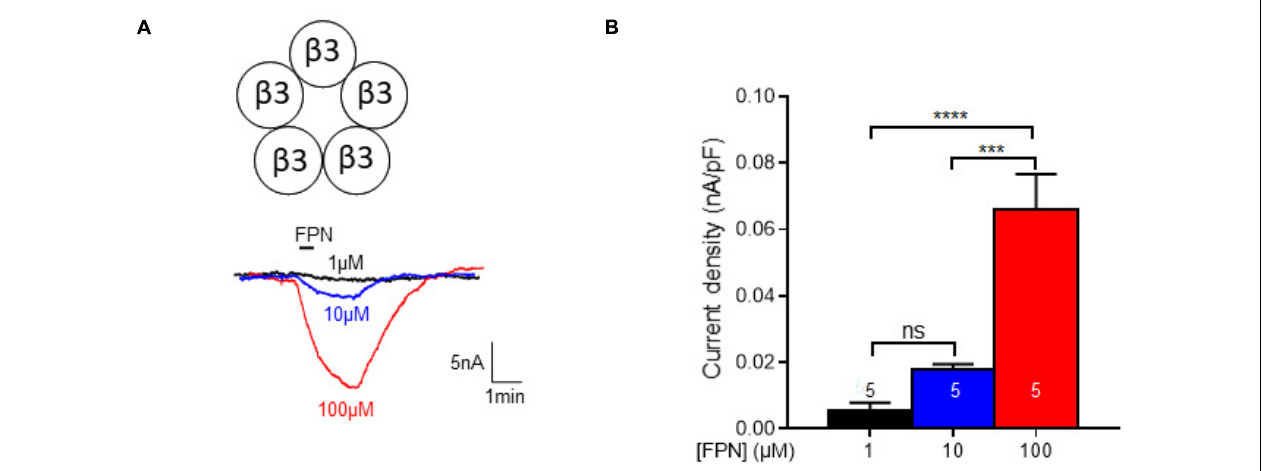
FIGURE 6 | Effect of FPN on leak currents elicited by expression of β 3-subunits in Xenopus oocytes. (A) Representative current traces obtained by increasing concentrations of FPN (1, 10, and 10 µ M). (B) Analysis of FPN-induced currents. The current density increases as a function of FPN concentrations: it was 0.0058 ± 0.0021 nA/pF, 0.0177 ± 0.0018 nA/pF, 0.0661 ± 0.0105 nA/pF for 1, 10, and 100 µ M FPN, respectively. The number of recorded oocytes is indicated inside the bars. Data are mean ± SEM of at least two independent experiments. Multiple comparisons were performed using one-way ANOVA tests followed by Tukey’s post hoc correction (*** p < 0.001, **** p < 0.0001, ns, not